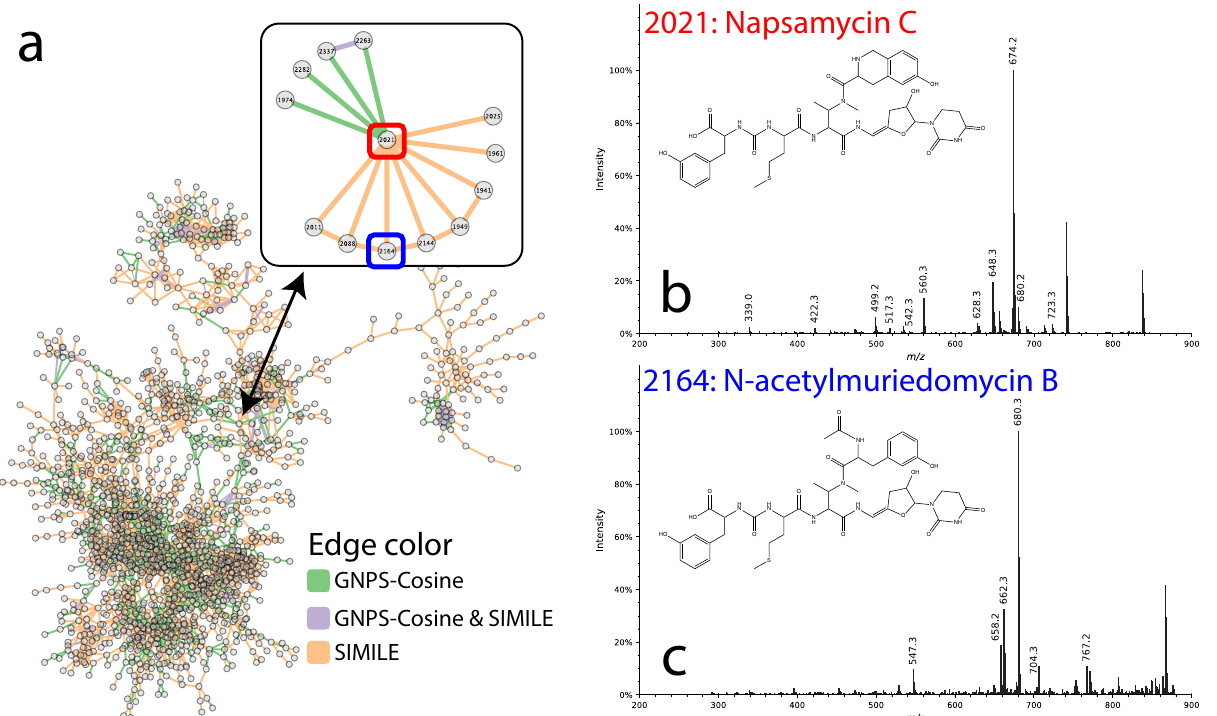
Fig. 5 Starting with a spectrum from node 2021, which was identi fi ed as Napsamycin C from traditional molecular networking work, SIMILE found additional connections that would have been missed if only cosine scoring was used. The network shown in a contains edges from SIMILE, GNPS-Cosine, and both techniques. The connection to the spectrum from node 2021 shown in b was connected to the spectrum from node 2164 shown in c . Both spectra closely matched the spectra described for these compounds from published work (matching ions are shown) 22,23 . The cosine score between these two spectra is near